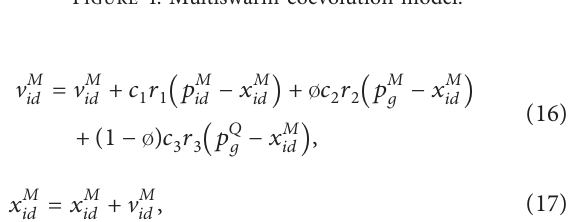
Figure 4: Multiswarm coevolution